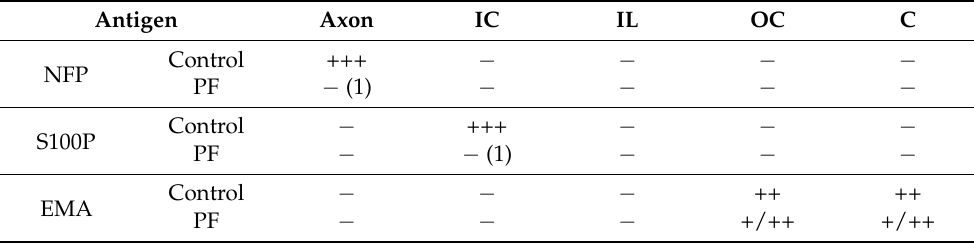
Table 2. Immunohistochemical profile of Pacinian corpuscles in normal plantar fascia (C) and plantar fibromatosis (PF). Quantification of the immunostain was performed considering absence